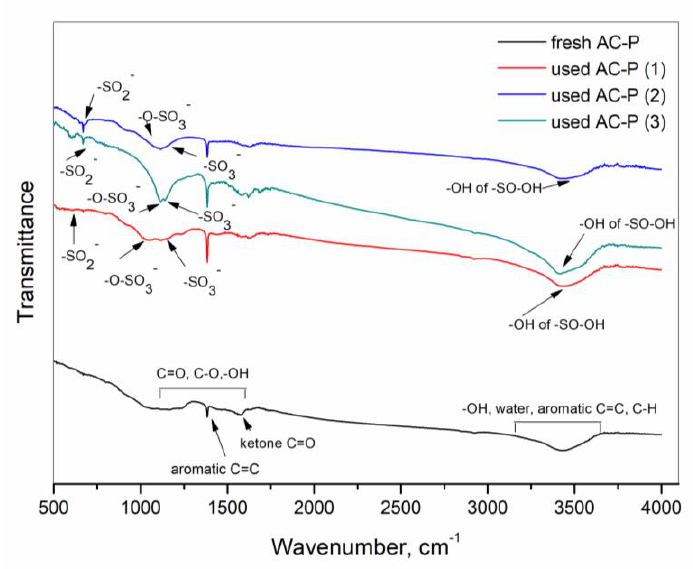
Figure 6. FTIR profiles of impregnated activated carbon: fresh and after use in the deSO x and deNOx adsorber: fresh AC-P, used AC-P (1), used AC-P (2), and used AC-P (3). adsorber: fresh AC-P, used AC-P (1), used AC-P (2), and used AC-P